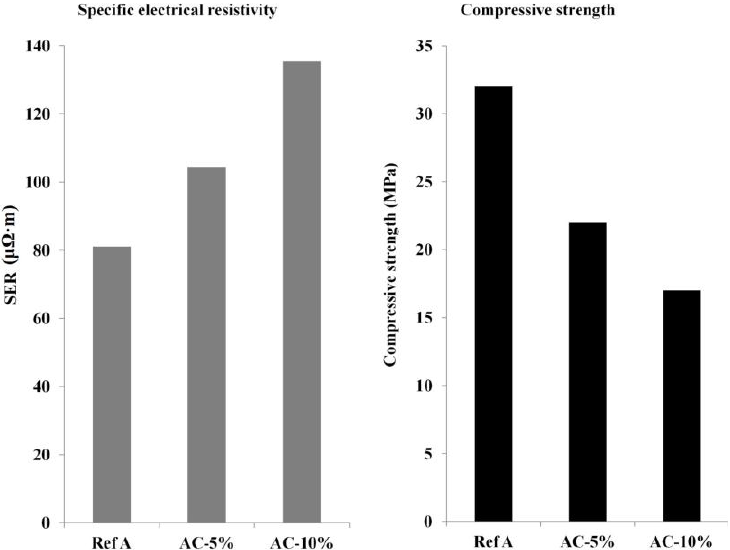
Figure 2. Specific electrical resistivity and compressive strength of anodes with different amounts of charcoal. of